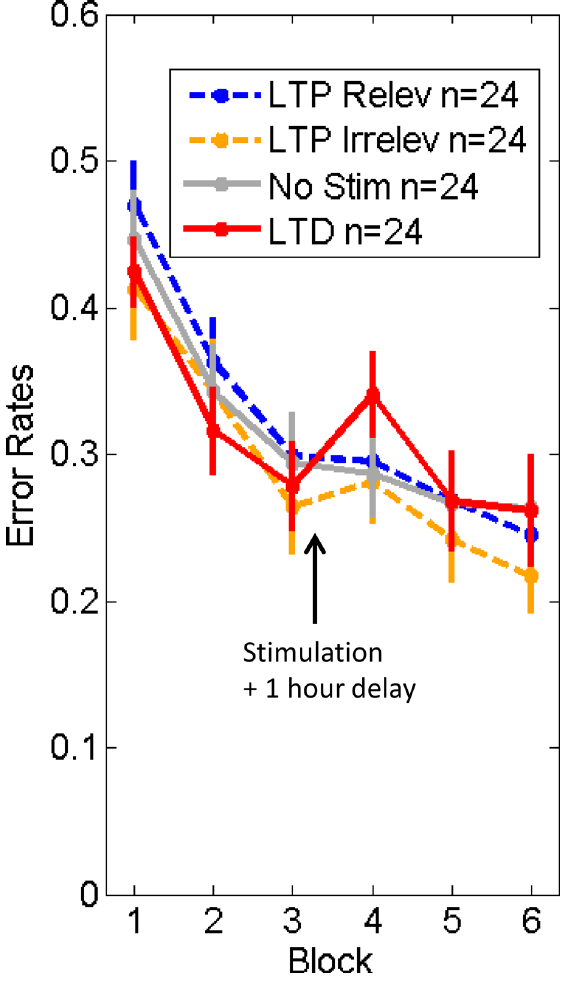
Fig 4. Experiment 3 (one hour delay post-stimulation). Error rates on ‘ competitive trials ’ for each stimulation condition: LTP relev = high-frequency relevant stimulation (face identity changes); LTP irrelev = high-frequency irrelevant stimulation (head orientation changes); No Stim = control group (without stimulation); LTD = low-frequency relevant stimulation (face identity change). See Results. Error bars = +/- 1 SEM across